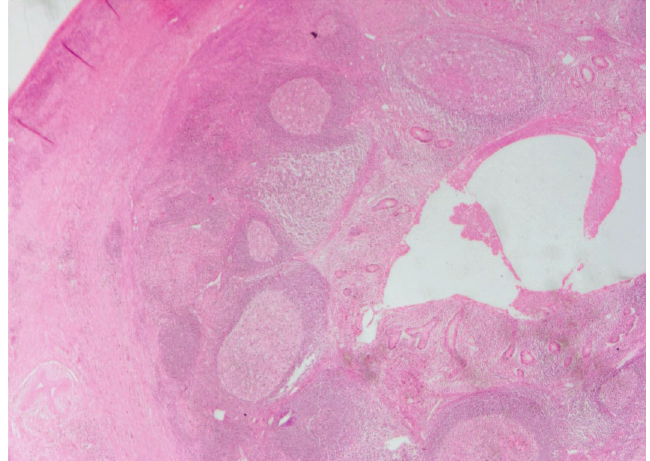
Figure 2: Histopathological specimen of a case of appendicitis caused by Yersinia spp. demonstrates lymphoid hyperplasia and suppurative granulomas. (Image obtained with permission from Weisenberg